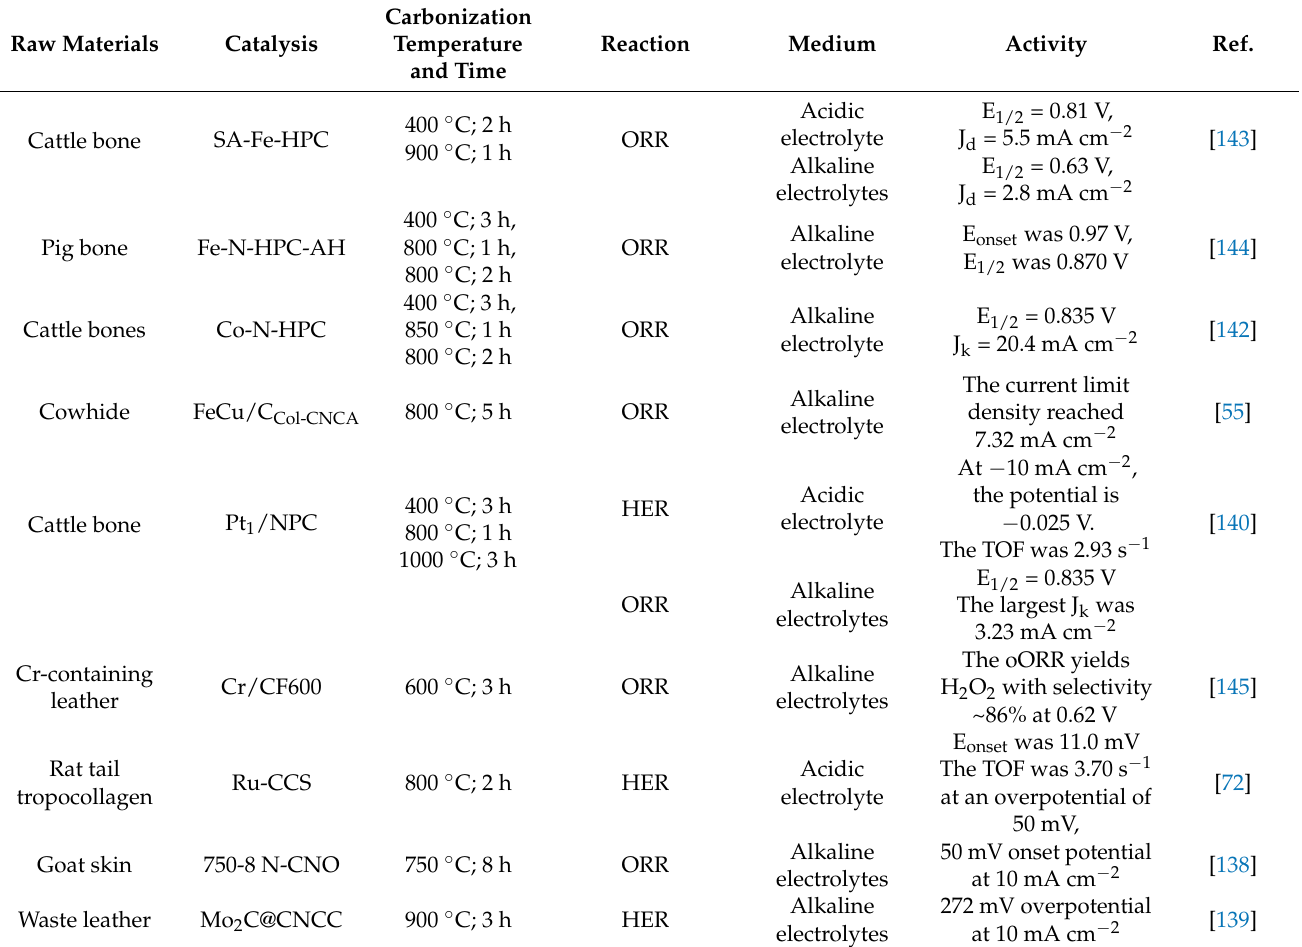
Table 2. Collagen-derived carbon catalysts for